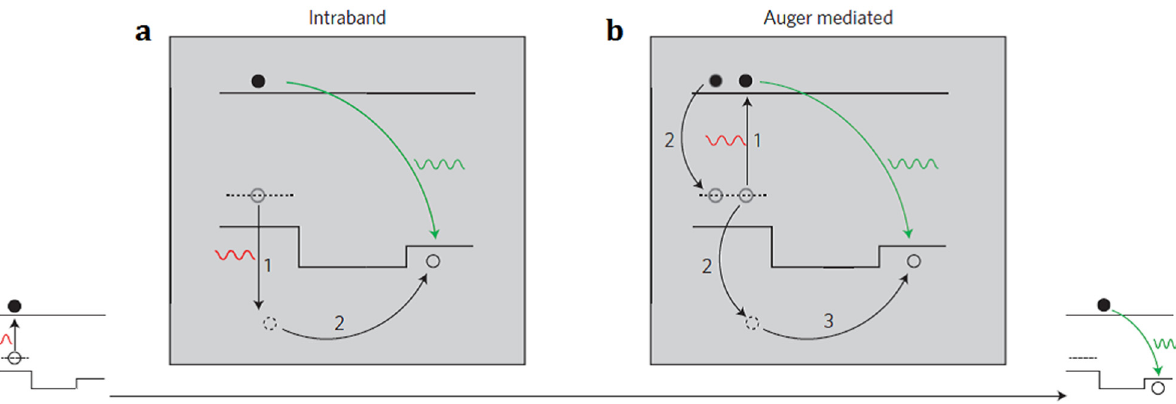
Figure 5. Mechanism of the upconversion in quantum nanostructures: ( a ) Direct intraband hole absorption mechanism of upconversion; ( b ) Auger-mediated upconversion (adapted with permission from [30]; Copyright Nature Publishing Group,